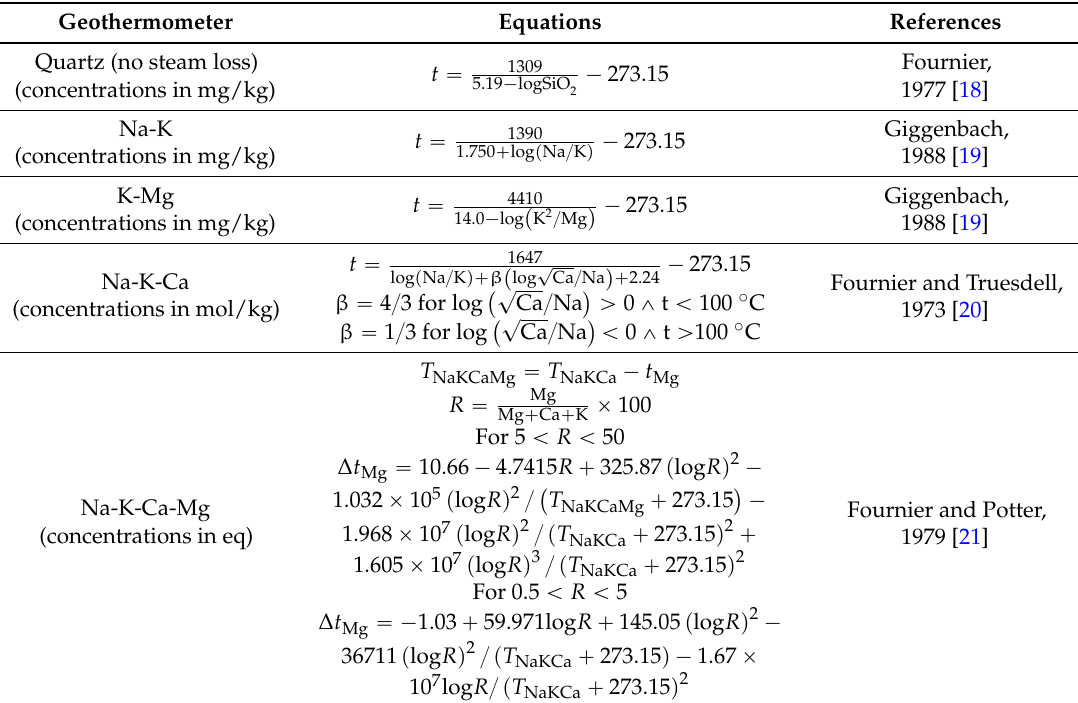
Table 1. Major solute geothermometers used in this